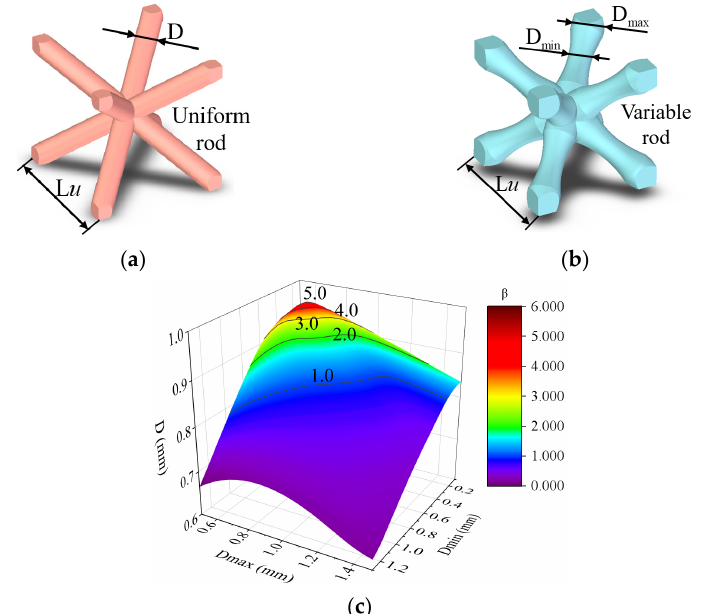
Figure 3. Geometries of uniform and variable cells: ( a ) uniform rod, ( b ) variable rod, and ( c ) bamboo bionic parameter β .